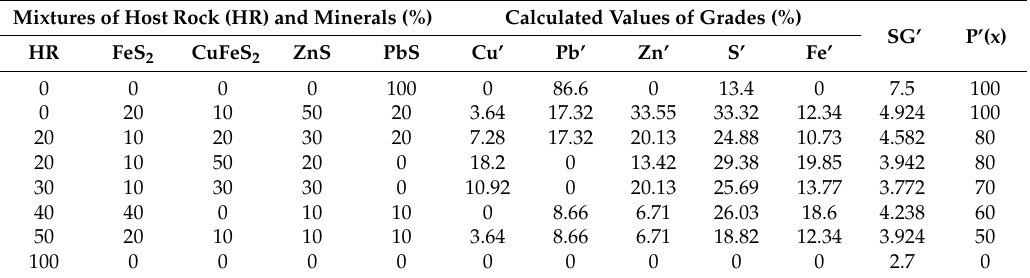
Table 2. Eight examples of mixtures of sulfide minerals and host rock and calculated grades of Cu, Pb, Zn, S, and Fe and SG and P ( x ).